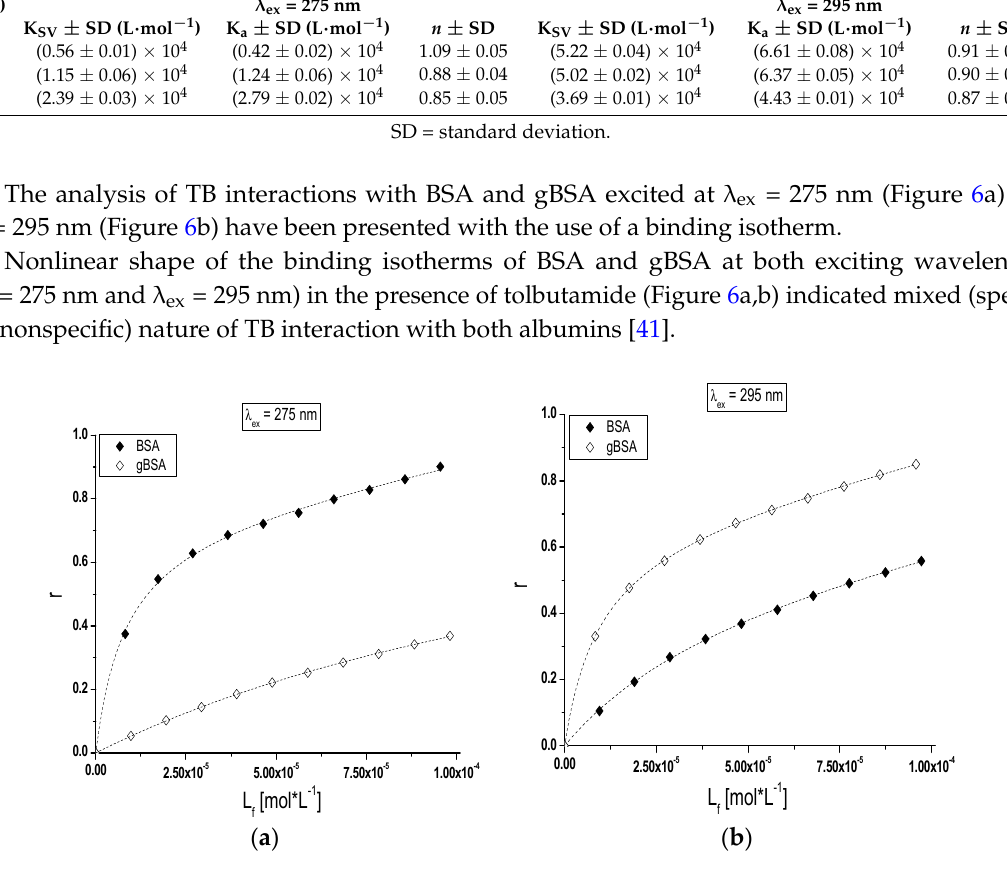
Figure 6. Binding isotherms of non-glycated (BSA, (cid:7) ) and glycated (gBSA, ♦ ) bovine serum albumin at 5 × 10 − 6 mol ∙ L − 1 concentration with TB at 1 × 10 − 5 mol ∙ L − 1 –1 × 10 − 4 mol ∙ L − 1 concentrations: ( a ) λ ex = 275 nm and ( b ) λ ex = 295 nm; T = 309 K. The error bars are smaller than the symbols.